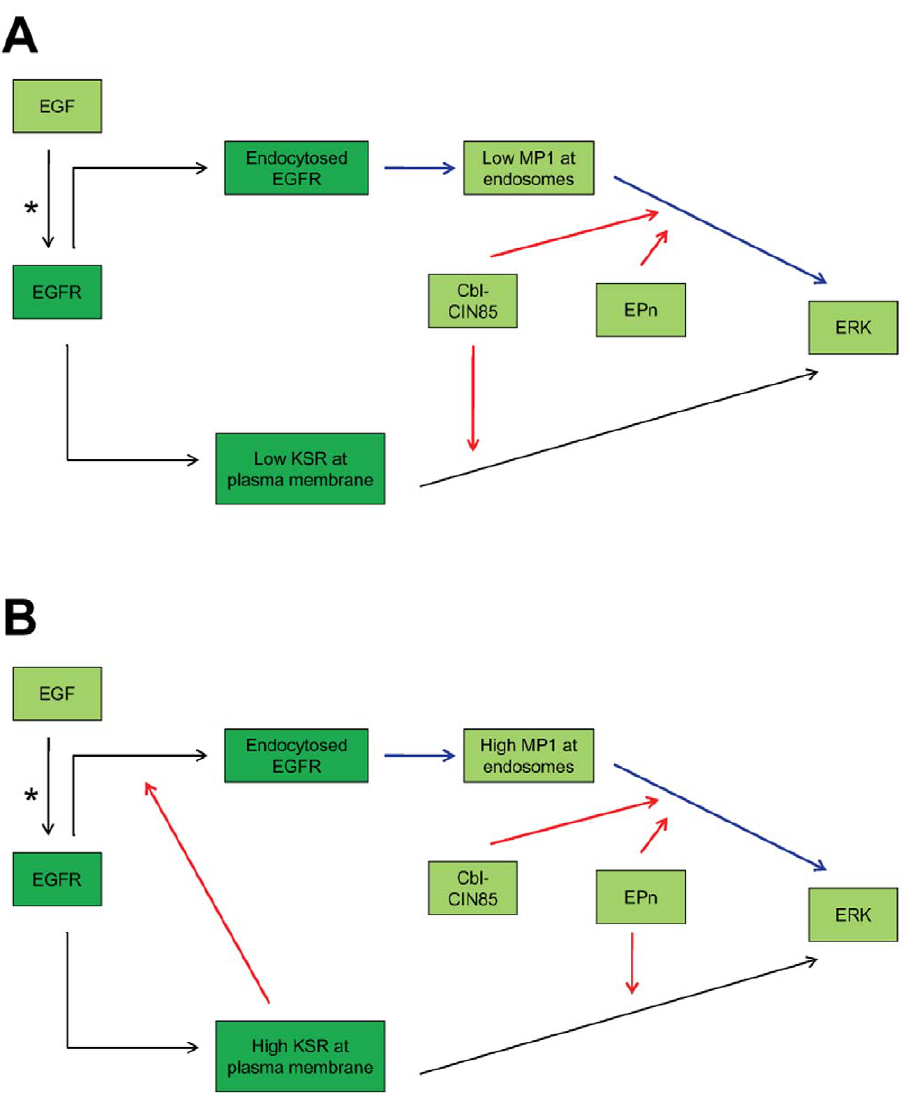
Figure 14. Distinct dynamics of EGFR endocytosis and ERK activation sensitivities mediated by scaffolds KSR and MP1, co- regulated by Cbl-CIN85 and Endophilin A1. EGF-induced ERK activation are collectively regulated at two different compartments (subpathways): near the plasma membrane (the conventional EGFR-Ras-Raf-MEK-ERK module and KSR-mediated signaling), and at late endosomes (MP1-mediated signaling). In this model, ( A ) when scaffold proteins are present at low levels, the two subpathways show distinctive sensitivities toward growth factor stimulation. MP1 exerts a more robust response to both endocytosed EGFR and ERK activation (lower sensitivity, denoted by blue lines) which could be influenced further by both Cbl-CIN85 and Endophilin (denoted by red lines). However, KSR has little effect on endocytosed EGFR but it affects sensitivity of ERK activation, co-regulated mainly by Cbl-CIN85 (denoted by red line) and not by Endophilin A1. ( B ) When both scaffold proteins are present at high levels, the sensitivity of endocytosed EGFR becomes milder and ‘‘analog-like’’ for the endosomal ERK activation (denoted by blue line) which is also co-regulated by both Cbl-CIN85 and Endophilin (denoted by red lines). However, high levels of KSR could now exert greater influence on the sensitivity of endocytosed EGFR (denoted by red line) to become more ‘‘digital’’ while the sensitivity of ERK mediated by KSR is further regulated more profoundly by Endophilin A1 (denoted by red line) but less by Cbl-CIN85. For further clarify, light green boxes denote components contributing towards lower sensitivity, high green boxes denote components contributing towards higher